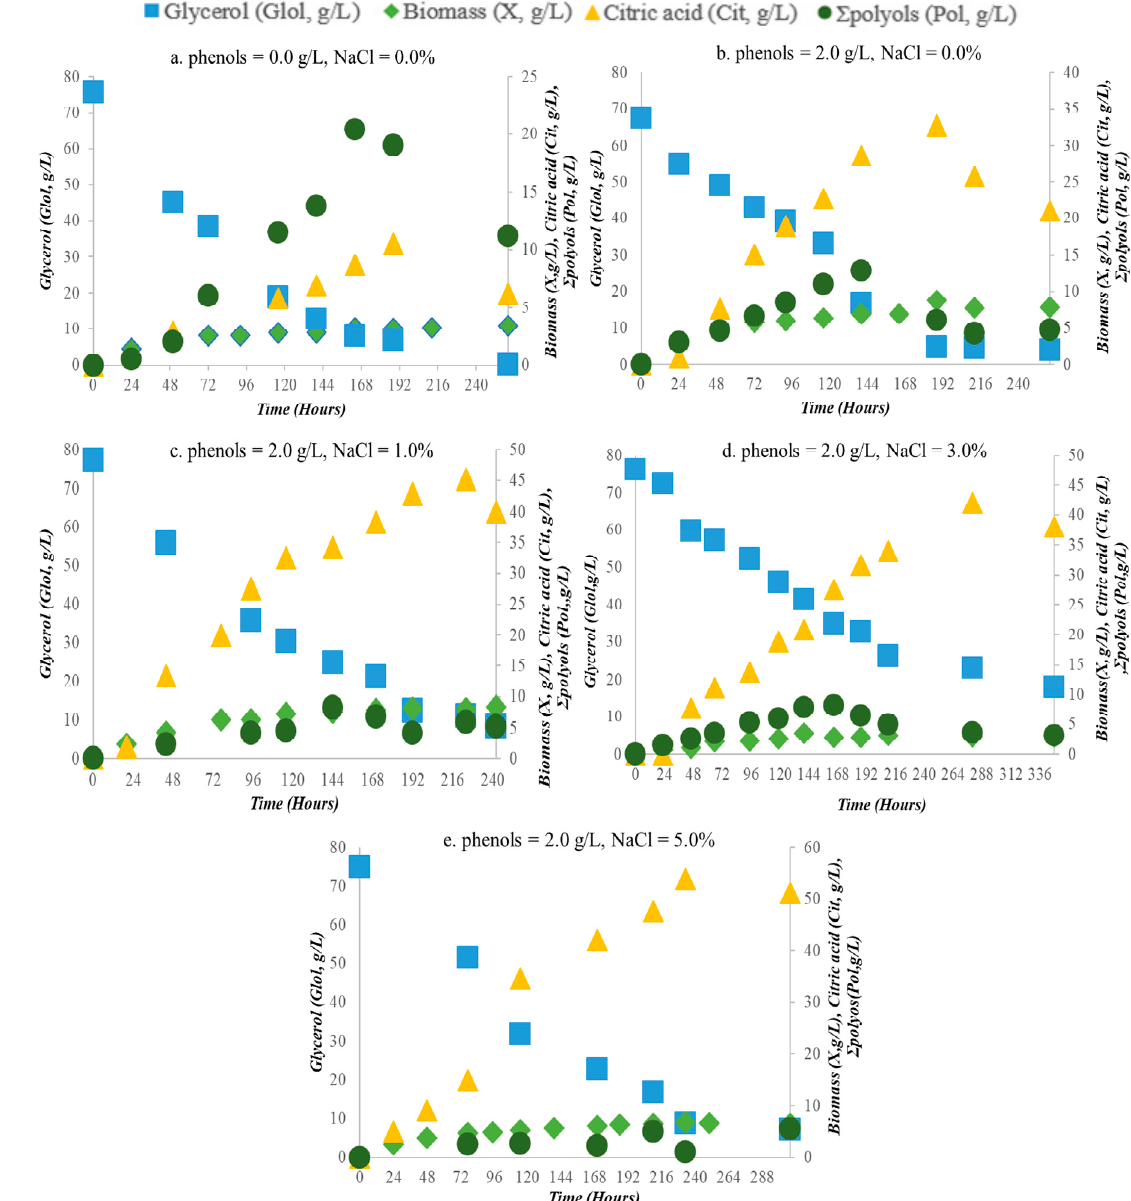
Figure 2. Kinetics of glycerol consumption (g / L), yeast Yarrowia lipolytica ACA-YC 5031 growth (DCW g / L), citric acid, and polyols production (g / L) in a glycerol-based culture medium containing ( a ) phenols = 0.0 g / L and NaCl = 0.0%; ( b ) phenols = 2.0 g / L and NaCl = 0.0%; ( c ) phenols = 2.0 g / L and NaCl = 1.0%; ( d ) phenols = 2.0 g / L and NaCl = 3.0% and ( e ) phenols = 2.0 g / L and NaCl = 5.0% concentration.